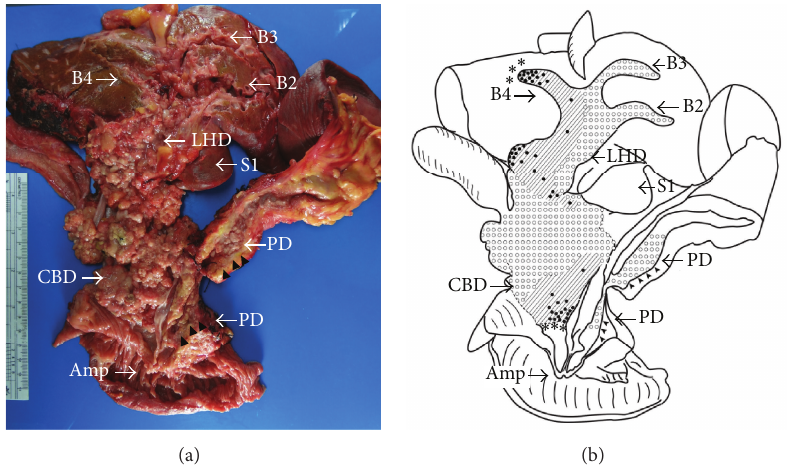
Figure 3: The surgical specimen and a schematic illustration of histopathology grading. (a) The surgical specimen of combined left trisectionectomy, pancreaticoduodenectomy, and total pancreatectomy. The picture shows the opening along extrahepatic bile duct and cut surfaces of liver and pancreas that reveals numerous diffuse soft pink papillary growths occupying the whole extrahepatic bile duct (LHD, RHD, CHD, and CBD) and left intrahepatic segment ducts (B2–B4). The pancreatic head was accidently displaced; therefore, its pancreatic duct (PD) has been labeled by the use of arrow heads. The main PD was diffuse dilation with intraductal lesions prominent at the proximal part, and generalized atrophy of the pancreas parenchyma was noted. No lesion was seen in the gallbladder. (b) A schematic illustration of the surgical specimen histopathological grading showing areas with low-grade (white-dotted area), high-grade (shaded area), carcinoma in situ (black dot), and invasive carcinoma areas located beneath the schema (asterisk). Amp: ampulla of Vater, B2: bile duct of segment 2, B3: bile duct of segment 3, B4: bile duct of segment 4, CBD: common bile duct, CHD: common hepatic duct, LHD: left hepatic duct, PD: pancreatic duct, RHD: right hepatic duct, and S1: segment 1 of